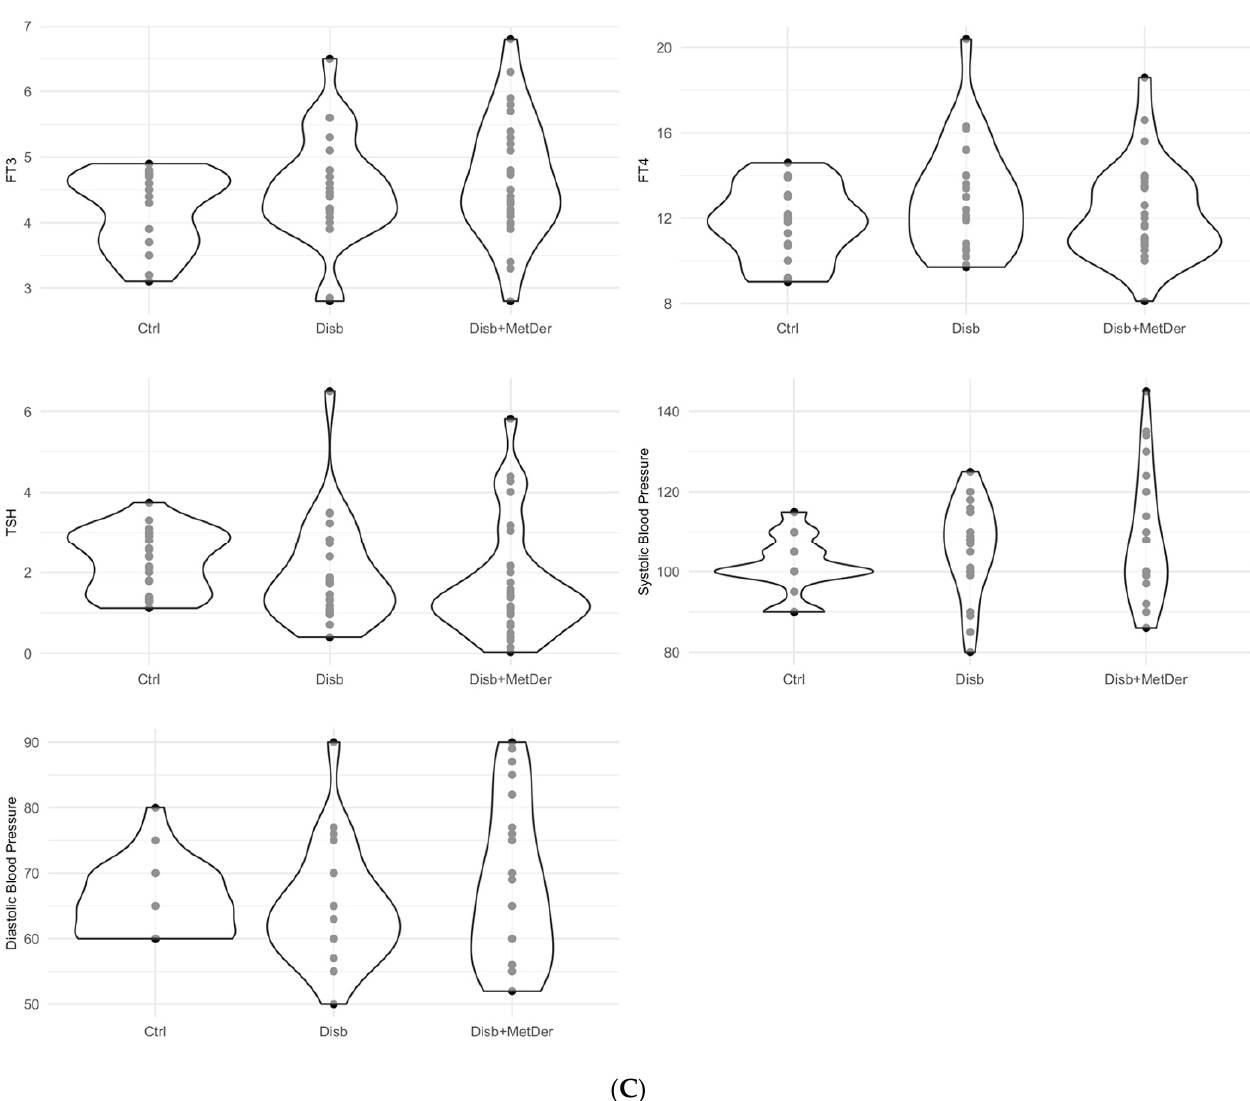
Figure A2. Correlation coefficients ( A ) and p -values ( B ) for the associations in PCA analysis.